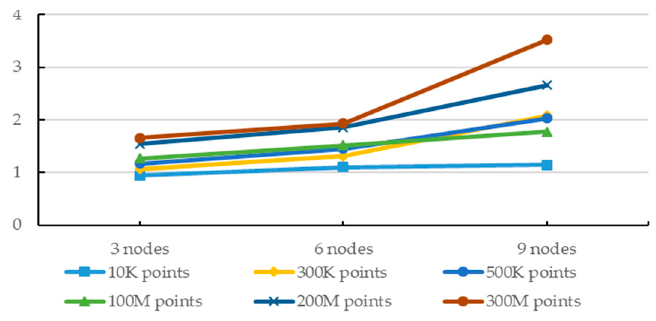
Figure 8. With different amounts of data, the ratio of the runtime of 1 node to the runtime of more nodes.